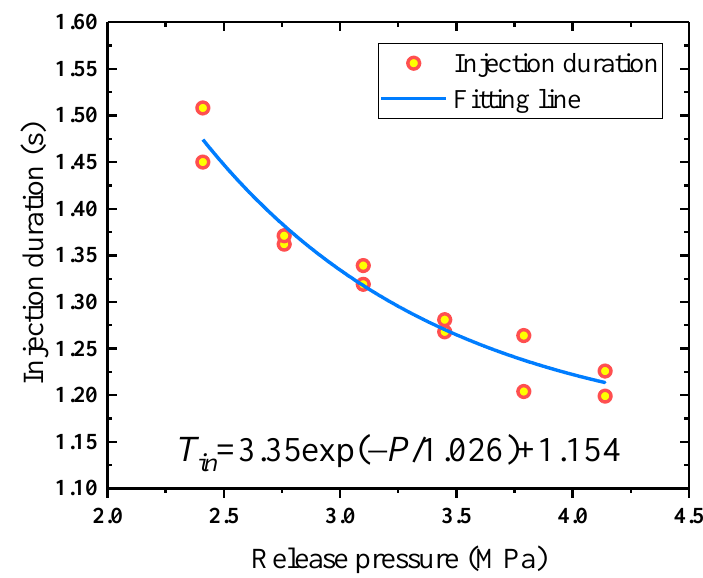
ff erent release